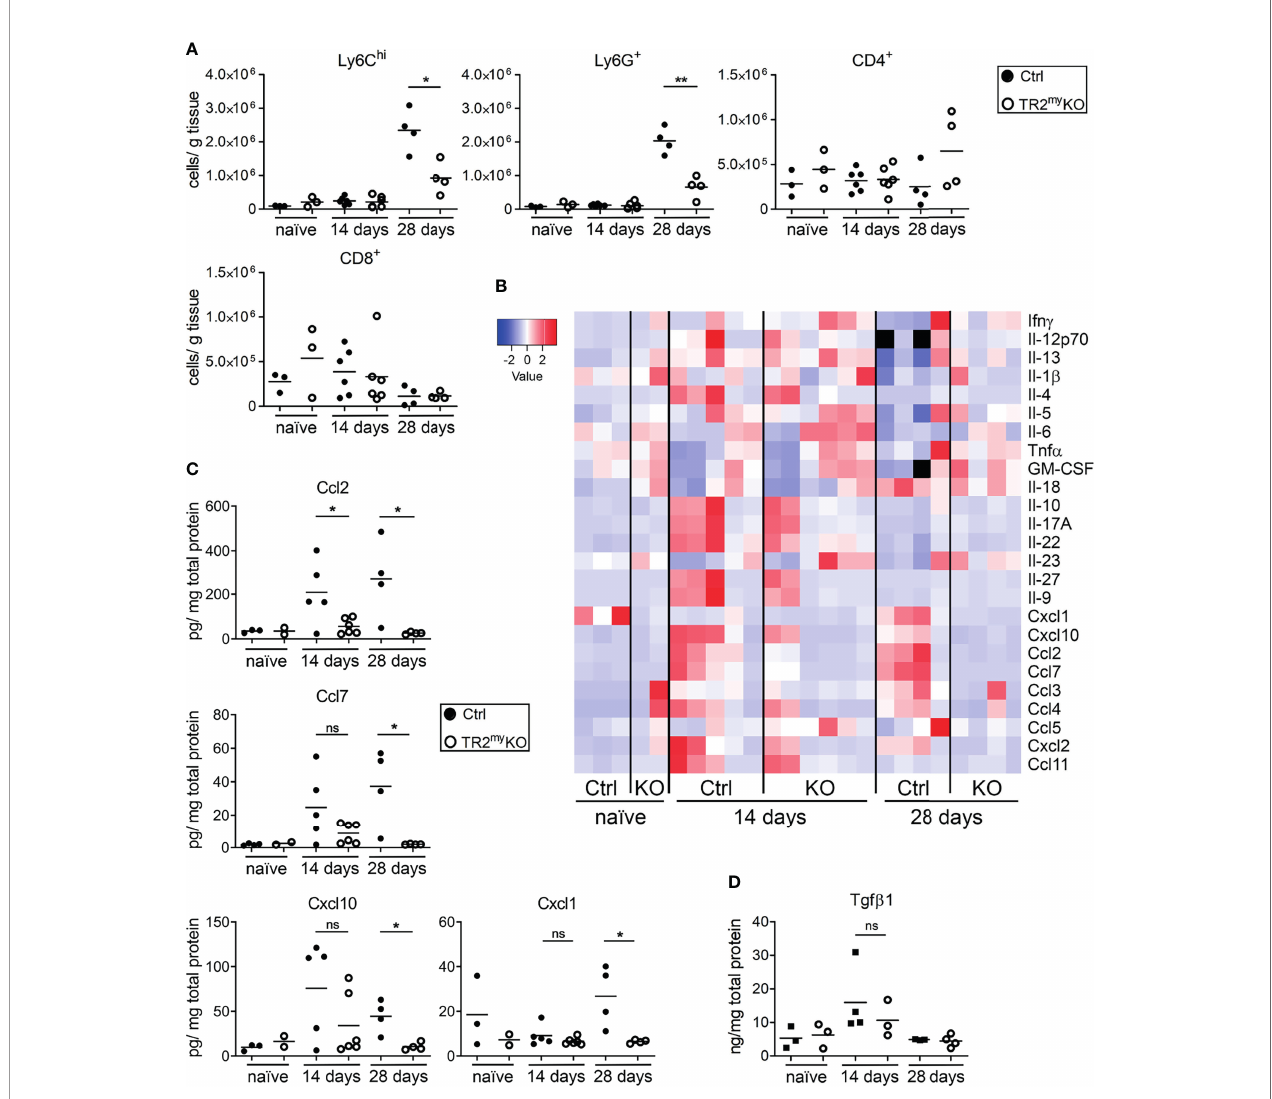
FIGURE 2 | Analysis of liver metastasis in Tgfbr2-myeloid cell-de fi cient mice. (A) Flow cytometry analysis of Ly6C hi , Ly6G + myeloid-derived cells and CD4 + and CD8 + lymphocytes in livers of TR2 my KO and Ctrl mice upon intrasplenic injection of MC-38GFP cells that were terminated at day 14 or 28, respectively; and compared to naïve mice. (B) Determination of cytokine amounts in the perfused liver homogenates of TR2 my KO and Ctrl mice at day 14 and 28 post-intrasplenic injection with MC-38GFP cells. (C) Quanti fi cation of selected cytokines amounts with signi fi cant changes among TR2 my KO and Ctrl mice samples. (D) Tgf b 1 levels in the liver of mice after intrasplenic injection of MC-38GFP cells 14 and 28 days post-injection when compared to naïve mice without any tumor cell injection. Statistical signi fi cance was assessed using Mann-Whitney test: ns, not signi fi cant; *p < 0.05; **p <